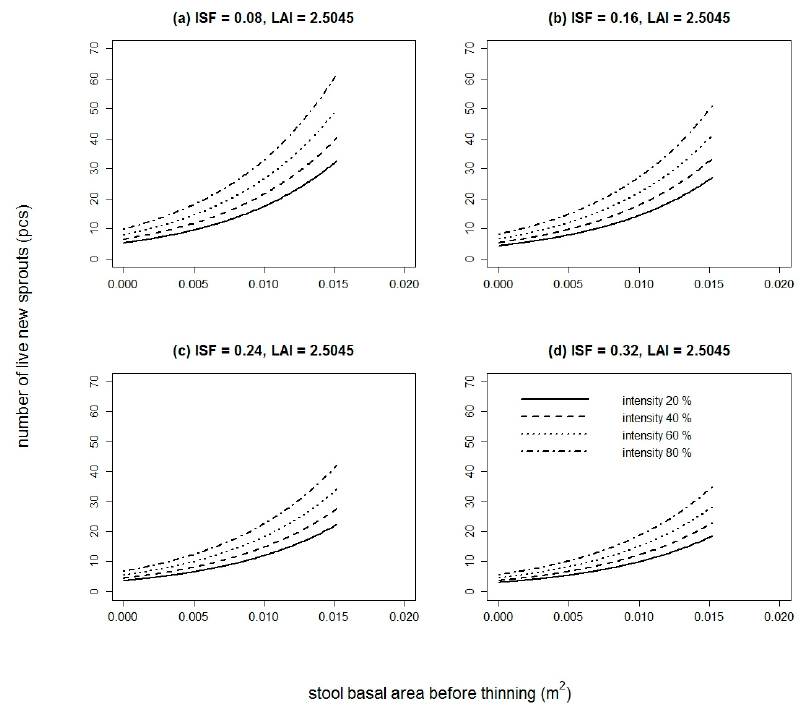
Figure 2. Fitted values of the number of live new European hornbeam sprouts model based on the stool basal area before thinning, thinning intensity, indirect site factor, and leaf area index (2016) (for the purpose of this figure, the mean value of LAI for European hornbeam stools is used). Forests 2017 , 8 , 308